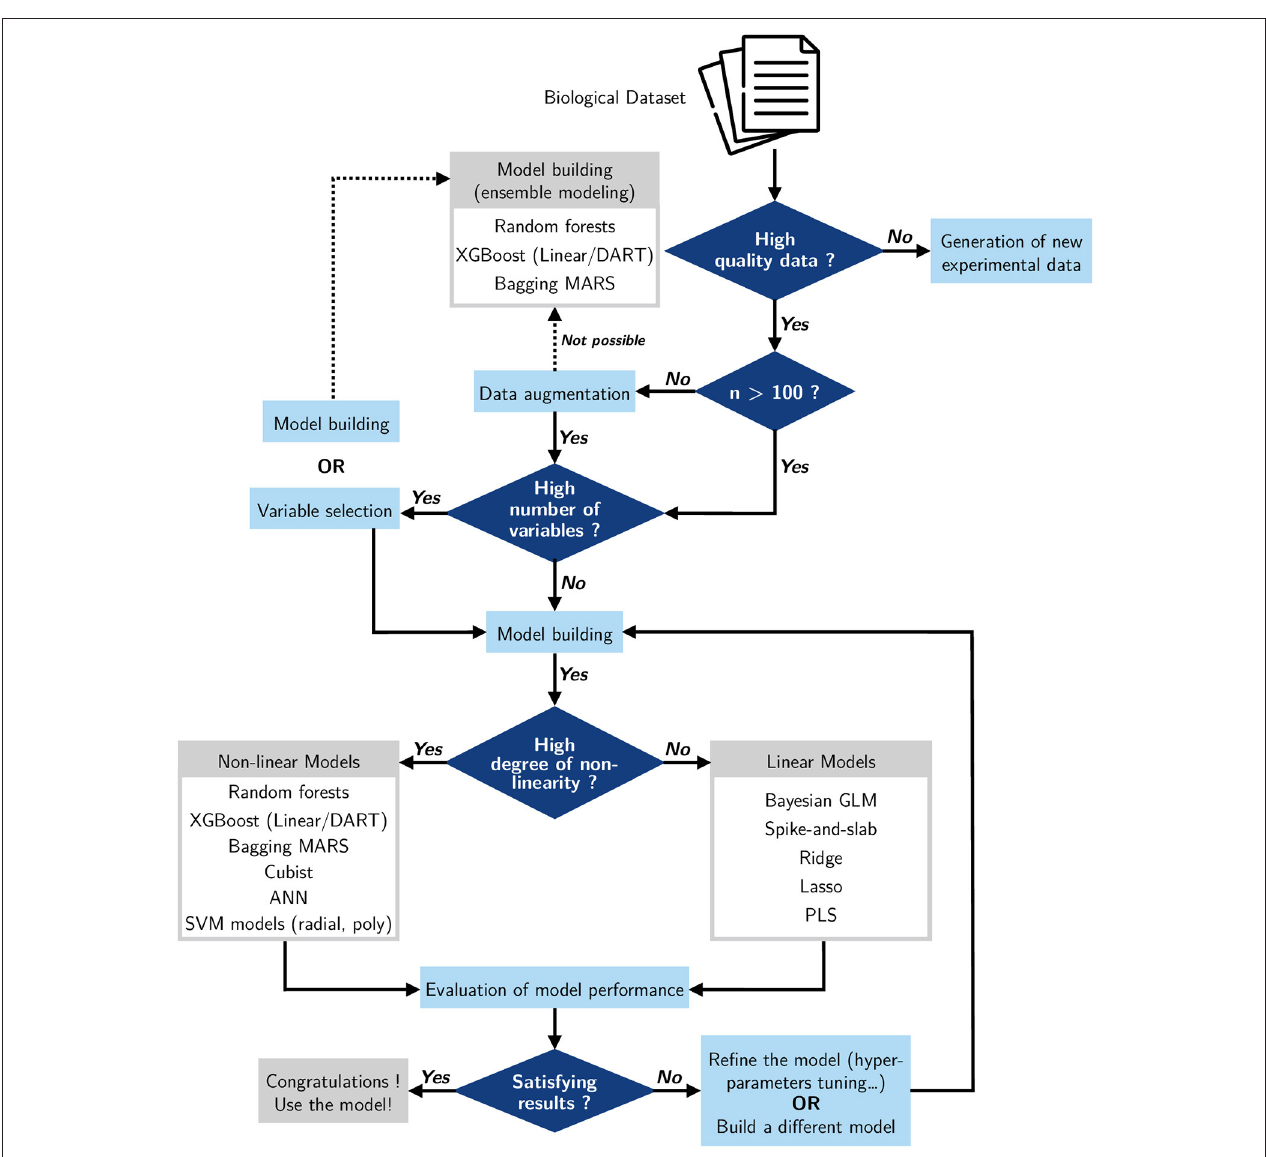
FIGURE 11 | Decision-making support for the construction of metabolic pathway models using machine learning methods.